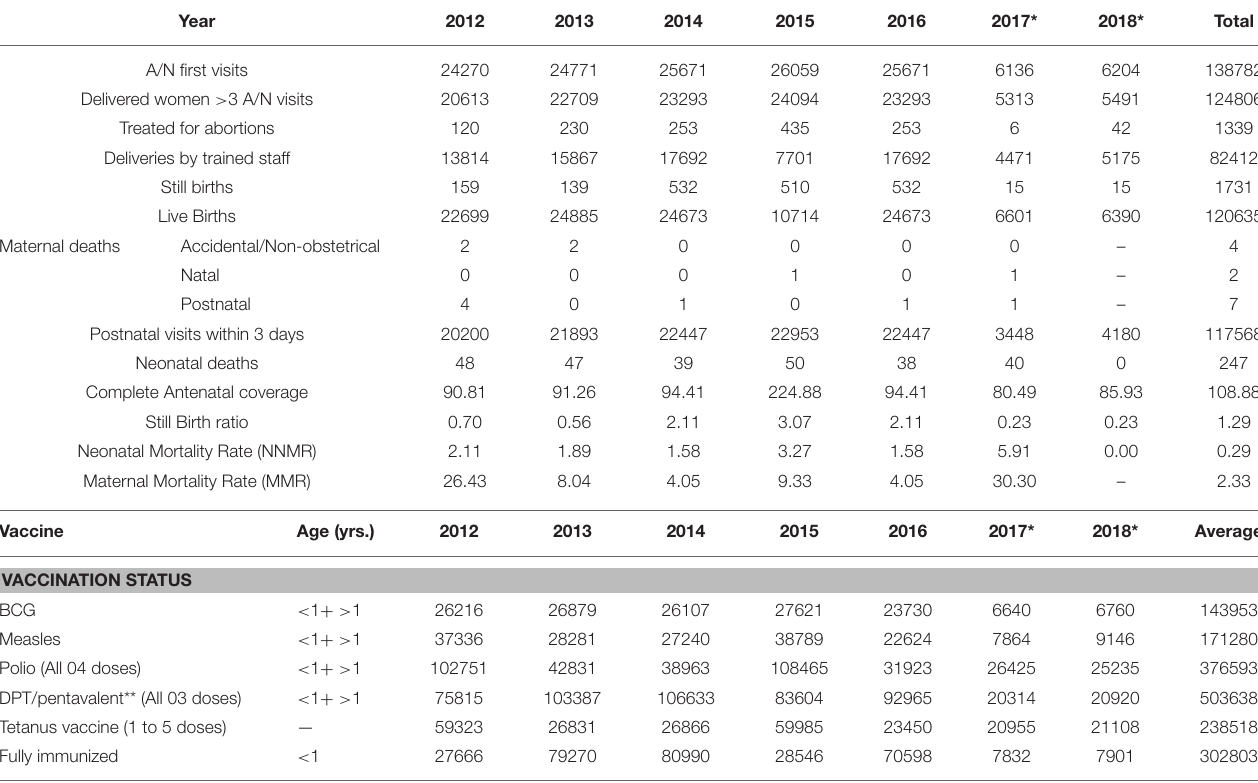
TABLE 3 | Mother and child health along with vaccination status among Afghan